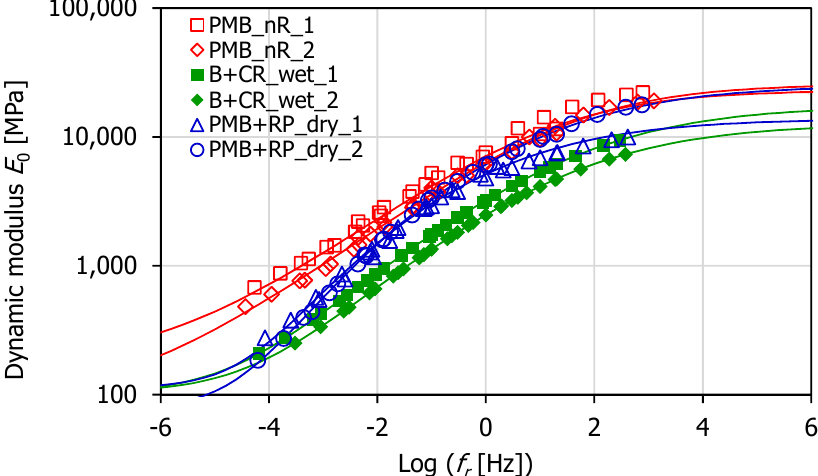
Figure 3. Master curves of the dynamic modulus at 20 °C.